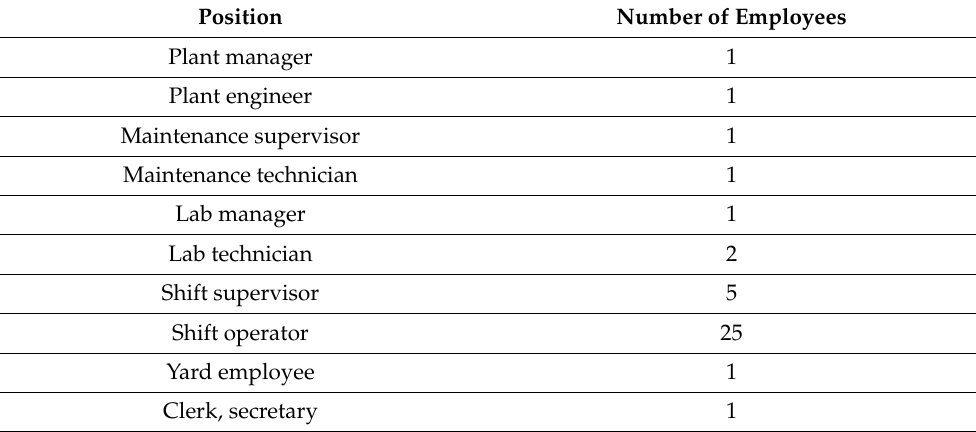
Table A6. Labour